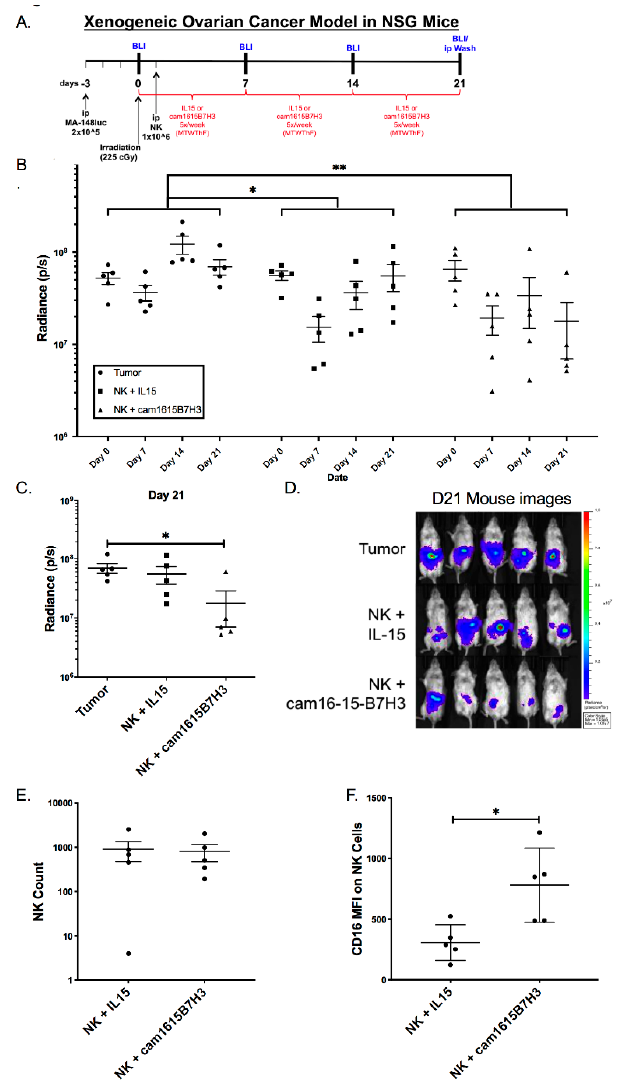
Figure 7. cam1615B7H3 TriKE is efficacious in subduing ovarian tumor progression in vivo. ( A ) Diagram showing Xenogeneic ovarian cancer MA-148-Luc model in female NSG mice (N = 5 per group). ( B ) Bioluminescent imaging indicative of tumor progression, measured as Total flux radiance ( C ) Bioluminescent imaging results on day 21 data point. ( D ) Graphed total flux radiance (p / s)